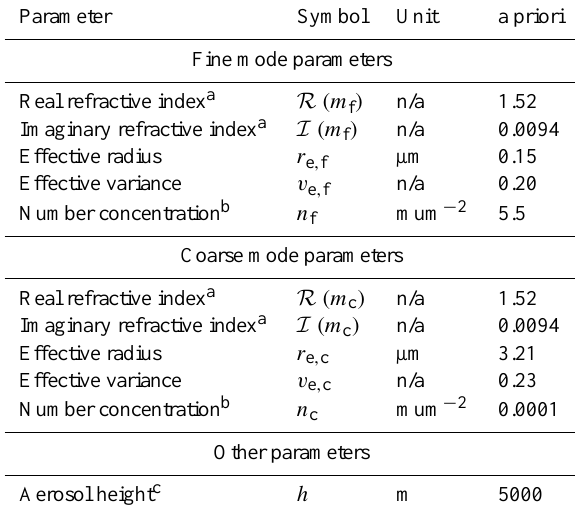
Table 1. Retrieved aerosol parameters and the initial values used in optimization. Parameters listed in italics are optimized during the retrieval, while all others are kept constant. a Refractive In- dex values have no spectral dependence. b For optimizations that utilize data from the HSRL, the a priori number concentration is determined by the HSRL observations. c For optimizations that uti- lize data from the HSRL, the aerosol layer height is fixed by HSRL observations and not changed during